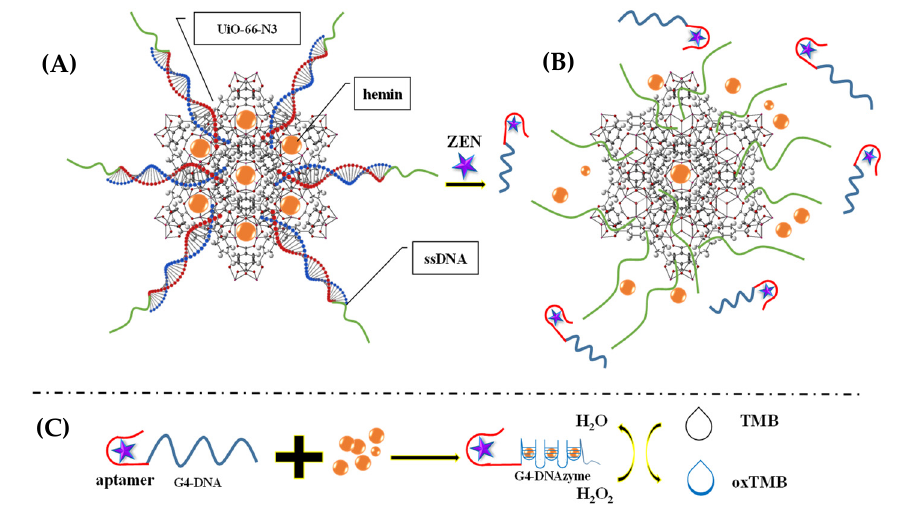
Figure 4. ( A ) Hemin-entrapped MOF synthesis gated by a duplex cDNA/ssDNA, where the ssDNA contains the trimeric G4-DNA sequence and the zearalenone aptamer sequence. ( B ) The following section describes how the zearalenone/aptamer complex releases the cDNA/ssDNA-gated, hemin- entrapped MOF. ( C ) Graphical depiction of the production of G4-DNAzyme and its catalytic function. Adapted with permission from the article of [65]. 2022, Elsevier.